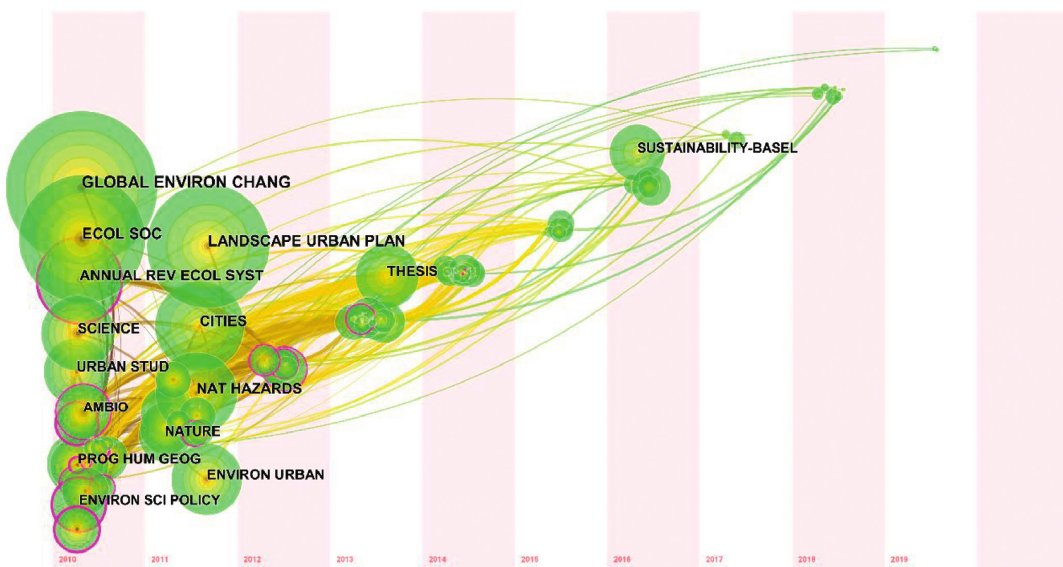
Figure 8: Time zone view of the co-citation journal network in resilient city research from 2010 to 2019. Table 5: Top 10 productive authors in the resilient city field from 2010 to 2019.